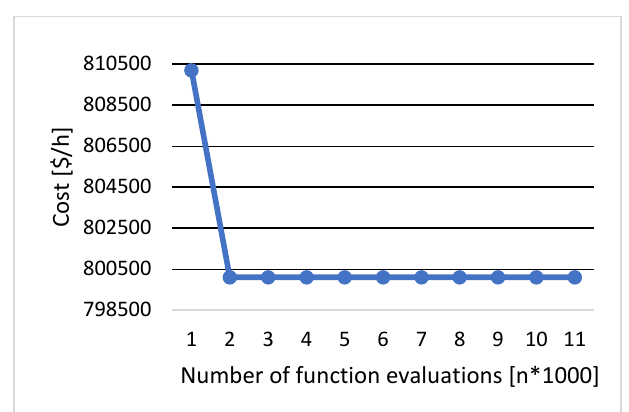
Fig. 10. Sunlight curve and PDF of Beta function Also, the distribution wind speed of the region is shown in Fig.11, which leads to the maximum wind speed of the region equal to 12 meters per second. The Weibull and Normal distribution curves of wind speed based on the obtained data are depicted in the black and the green diagram. The PDF of the Weibull is better and more appropriate than the Normal distribution. Furthermore, the a and b coefficients of the Weibull function are 2.79 and 1.50.